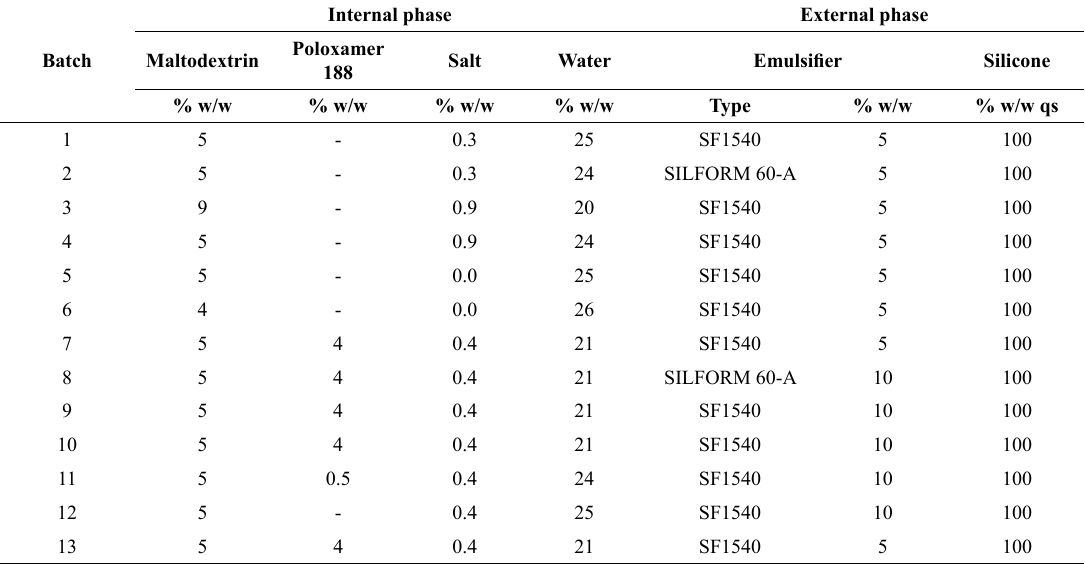
(Figure 2) of regular shape maltodextrin nanoparticles in silicone with a mean diameter ranging from 233 nm to 460 nm and polydispersity index ranging from 0.07 to 0.35 as shown in Table 2.